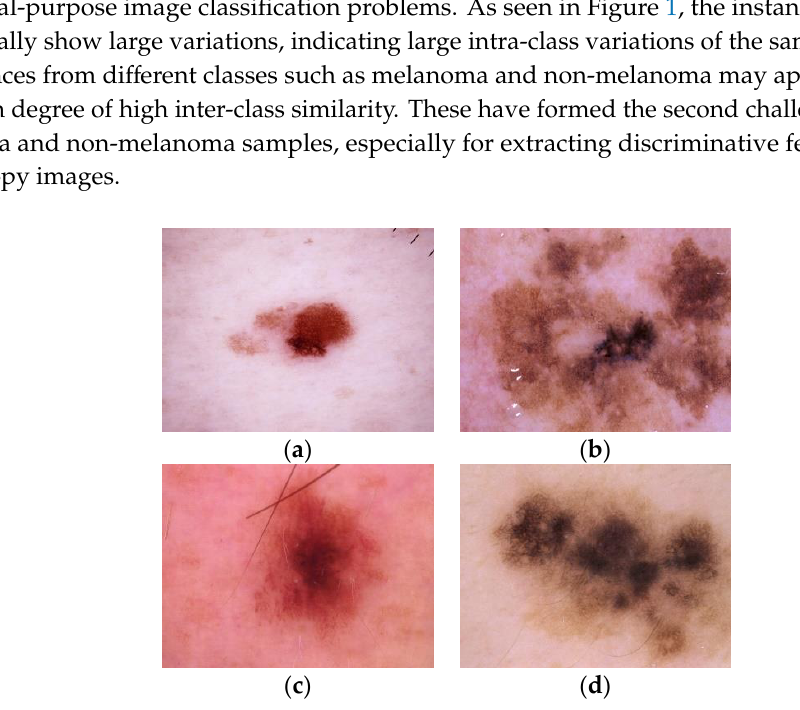
Figure 1. Melanoma and non-melanoma dermoscopy images. ( a , b ) The class of the top two images is melanoma, while ( c , d ) the class of the bottom images is non-melanoma. According to these four images, we can observe that there exists large intra-class variations and high inter-class similarity of the skin lesions.